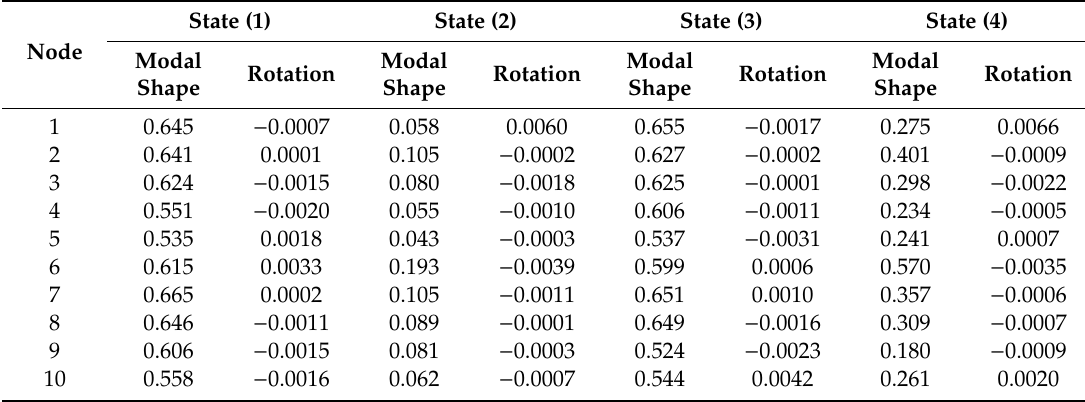
Table 4. The first-order modal shape based on accelerometer.